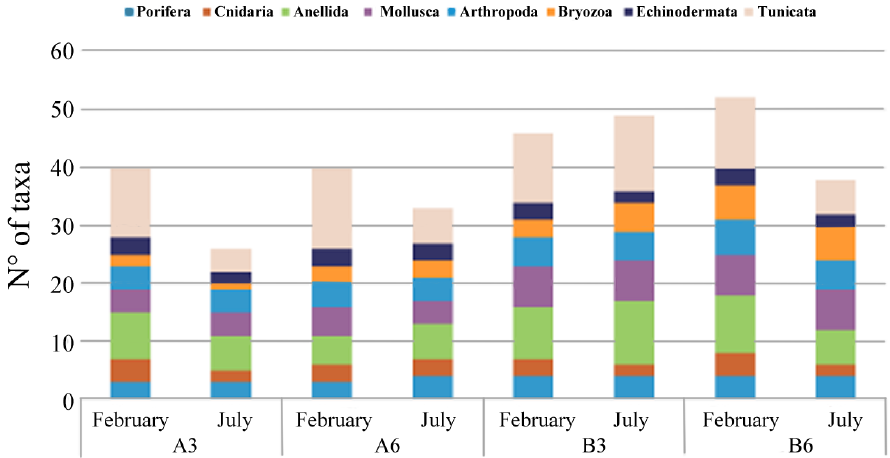
Figure 4. Hard substrate taxa abundance detected at each sampling site (A3, A6, B3, and B6) in February and July 2018. Soft bottom communities revealed the presence of 163 taxa, with polychaeta being the